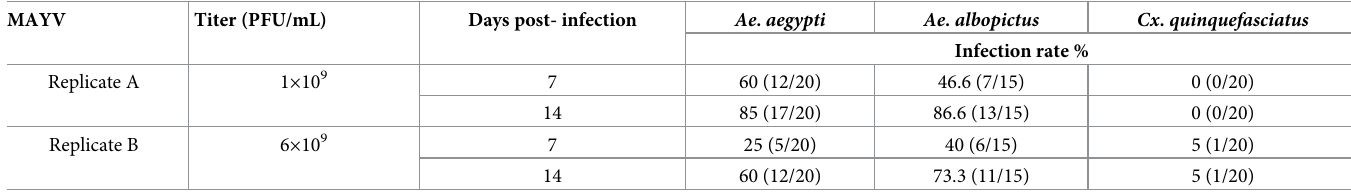
Table 1. Aedes aegypti , Aedes albopictus , and Culex quinquefasciatus orally infected with Mayaro virus. The initial viral titer was determined by plaque-forming units (PFU/mL). Infected/total mosquito numbers are shown parenthesis. MAYV Titer (PFU/mL) Days post-